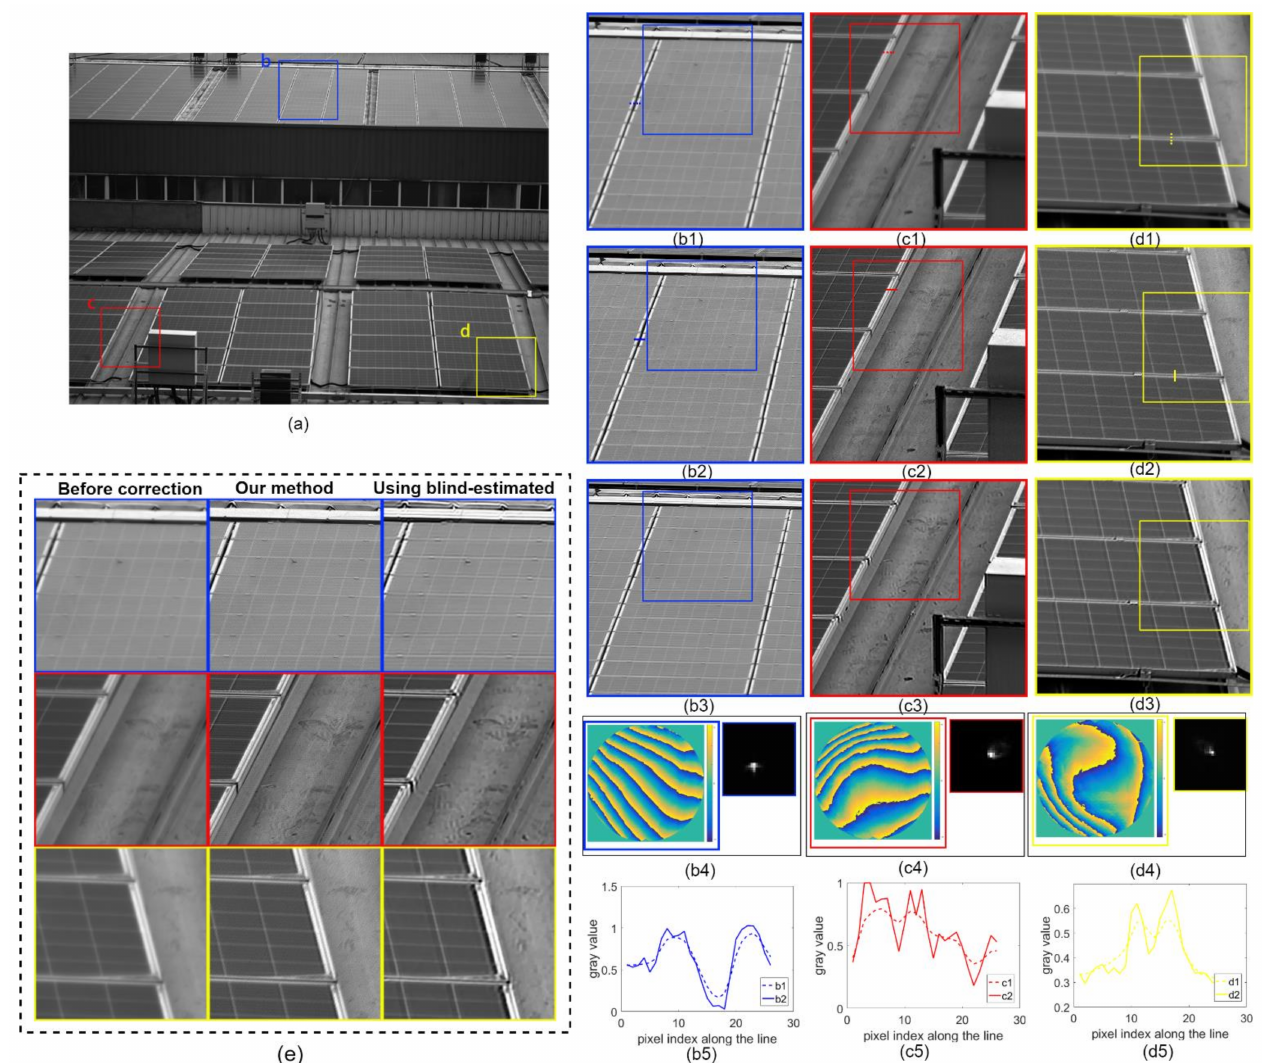
Figure 9. Results for the factory image. ( a ) Full FOV image captured by our inexpensive industrial lens. The pupil function and PSF of each small region denoted by ( b1 – d1 ) varied spatially, as shown in ( b4 – d4 ). The deconvolution results ( b2 – d2 ) show that the spatially varying aberrations were adequately corrected after processing. ( b3 – d3 ) The restored results using blind-estimated PSFs. ( b5 – d5 ) Line profiles at the underlined places in ( b1 – d1 ) ( b2 – d2 ) to show the improved image sharp- ness before and after correction using the proposed method. ( e ) The three images on the left are enlargements of the inset frames in ( b1 – d1 ), which are captured as blurred images in different FOV. The three images in the middle are enlargements of the inset frames in ( b2 – d2 ) and are the restored results corrected using the proposed method. The three images on the right are enlargements of the inset frames in ( b3 – d3 ), the results of the correction using the blind-estimation